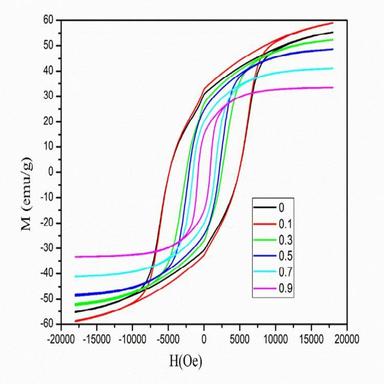
The M-H hysteresis loop of BaZnₓZrₓFe(12–2x)O19 (x=0, 0.1, 0.3, 0.5, 0.7, and 0.9)